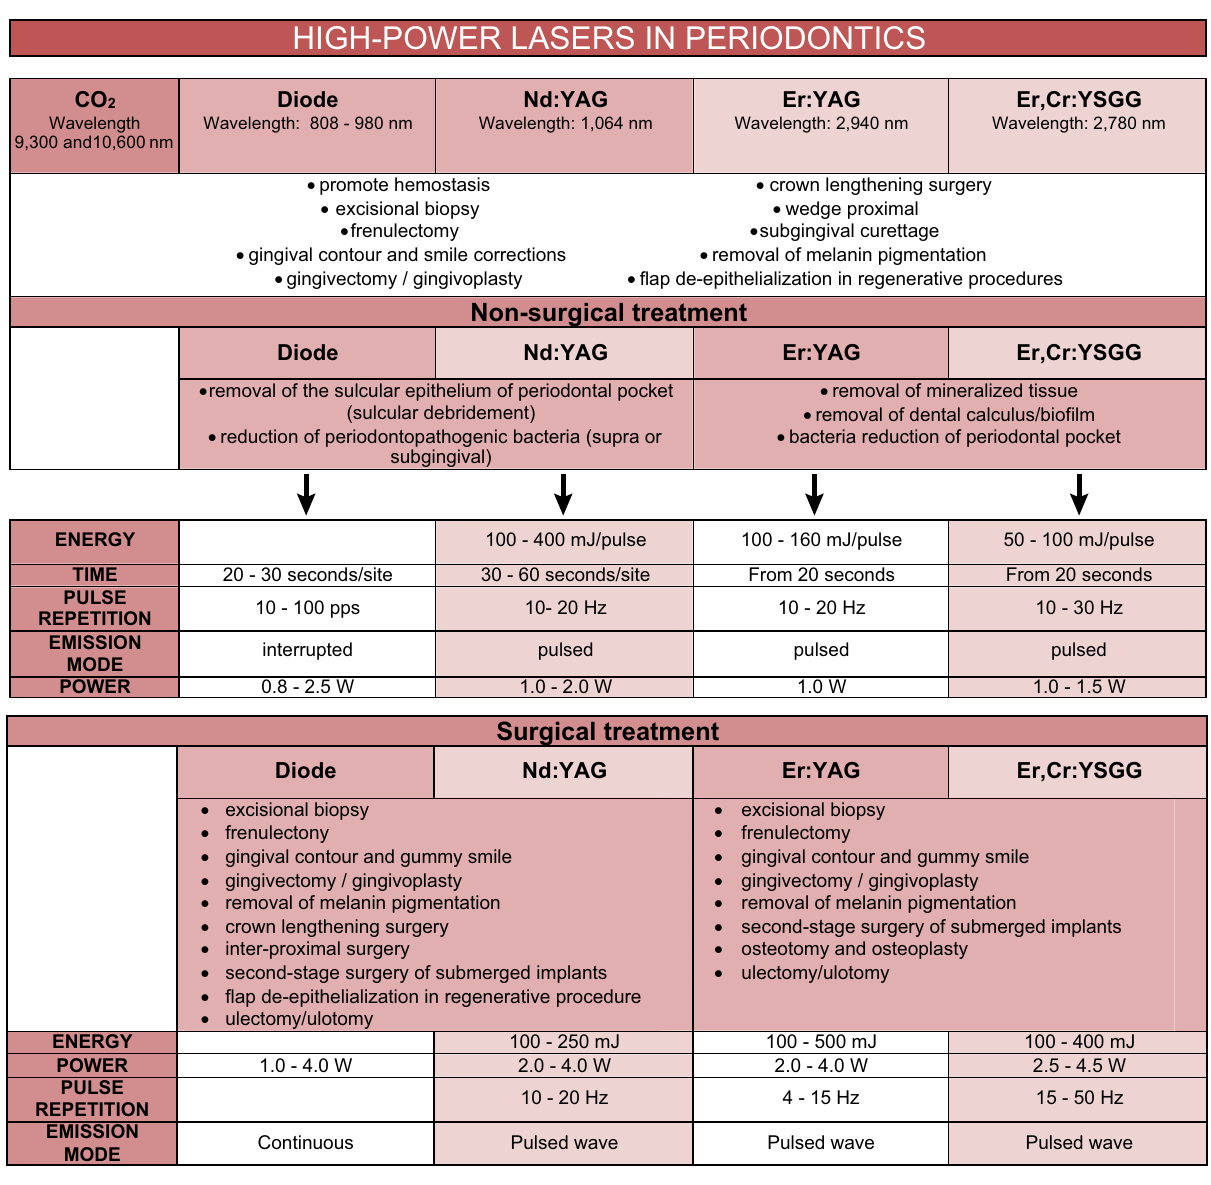
Figure 1. Indications and irradiation parameters of the high-power lasers described in the periodontal